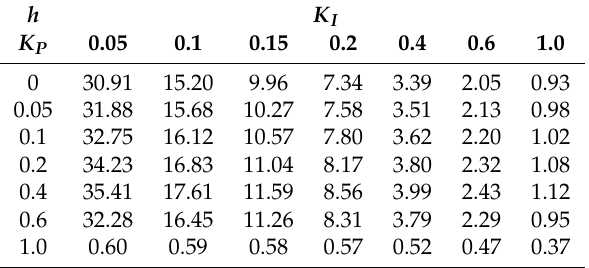
Table 3. Delay margins h ∝ Proportional-integral controller gains ( K P , K I ) (one-area LFC, µ = 0).